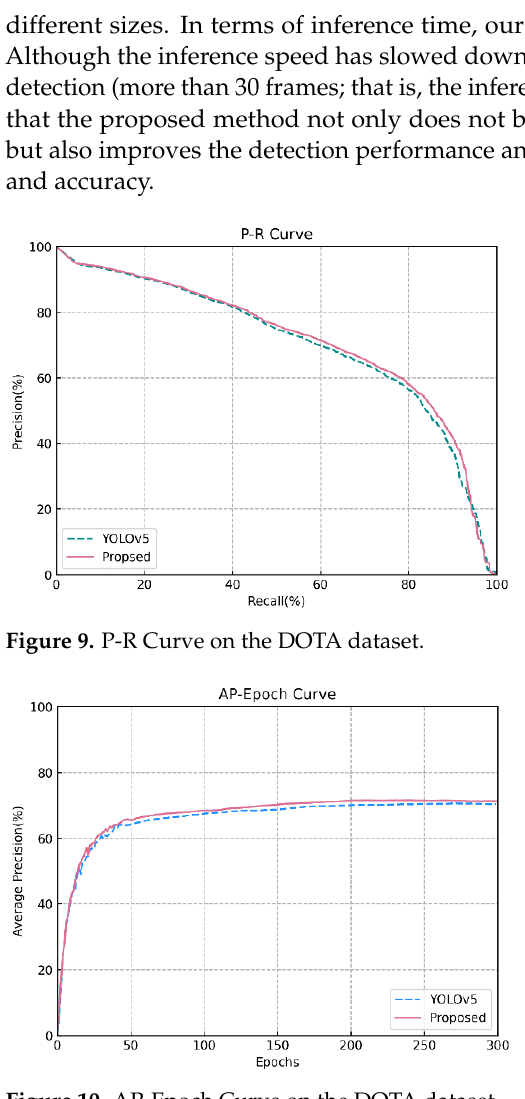
Figure 10. AP-Epoch Curve on the DOTA dataset. Table 6. Precision, Recall and AP